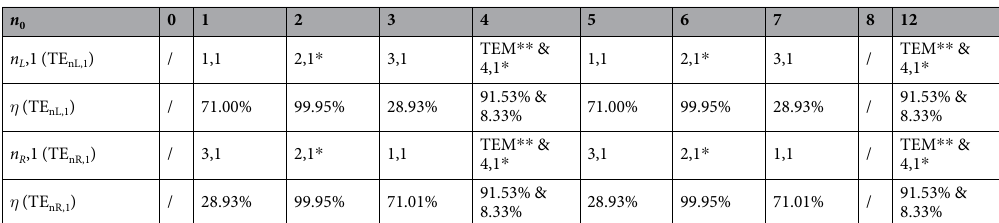
Table 2. Output mode components of the eight-cavity RM with their corresponding proportions in the coaxial waveguide in the cold simulations. * n L = n R indicates that the TE coaxial waveguide mode is linearly polarized, and the corresponding value of η is the simulation result for the linearly polarized mode. ** The TEM mode is neither linearly polarized nor circularly polarized, and the corresponding value of η is the simulation result for the TEM